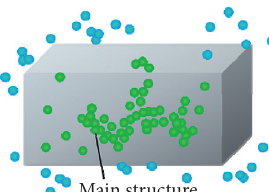
Figure 6: Schematic diagram of pass-through filter.